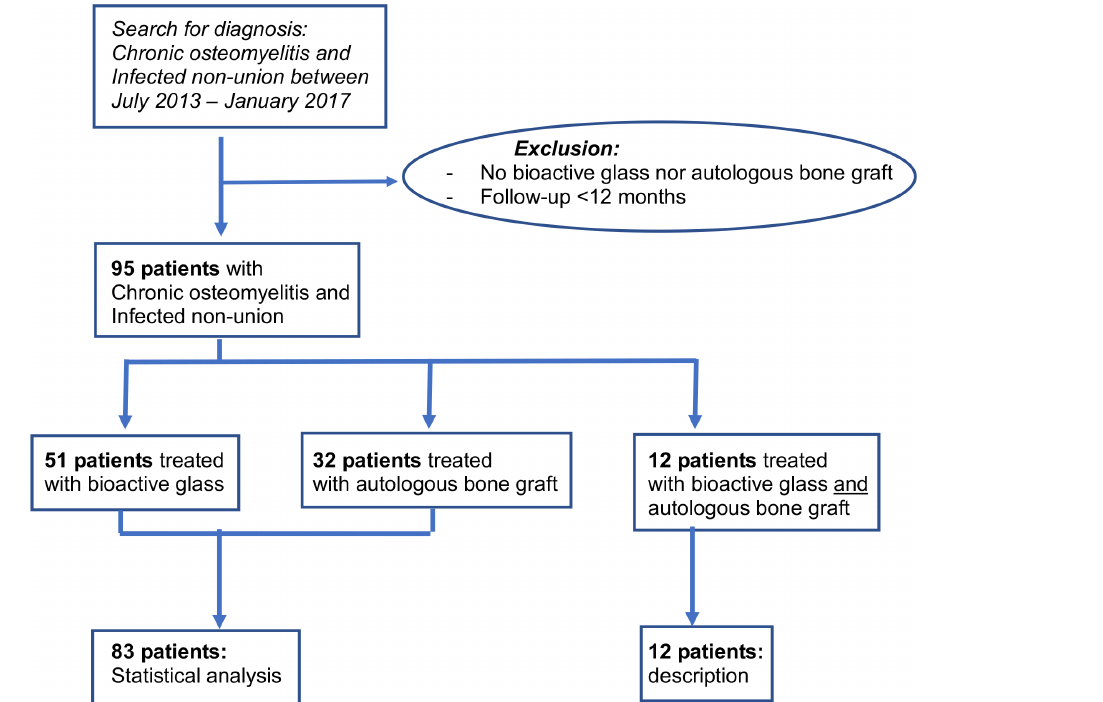
Figure 1. Flowchart of the patient recruitment